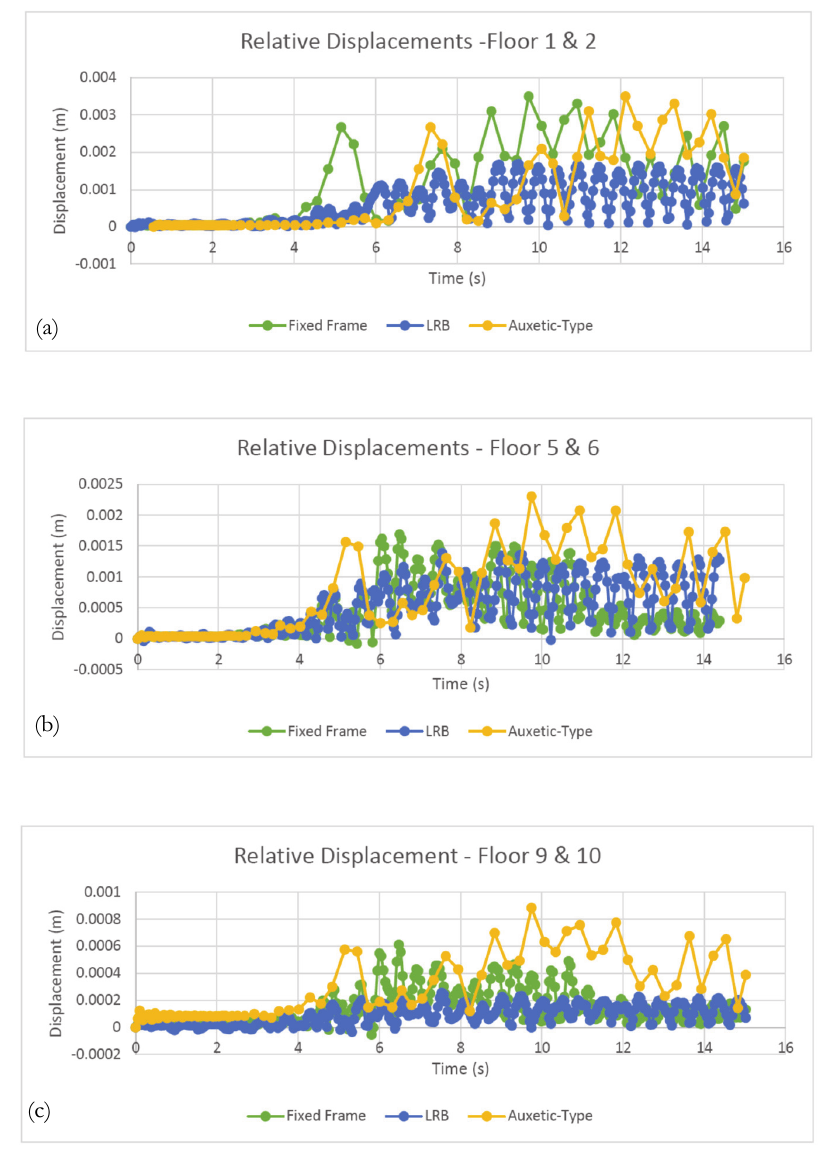
Figure 13: Relative displacement of floors (a) 1 and 2, (b) 5 and 6, (c) 9 and